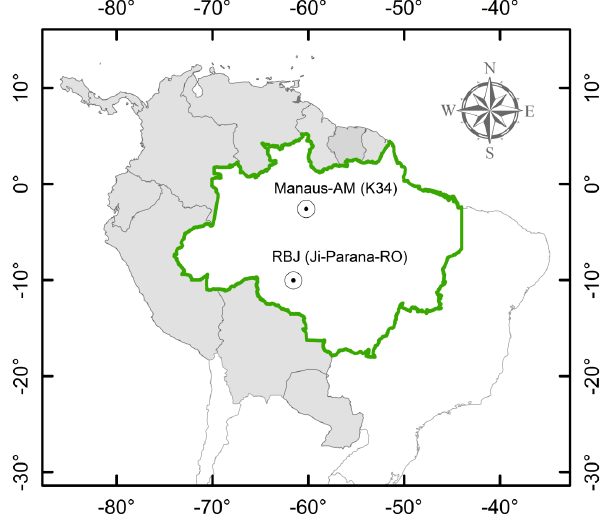
Figure 1. Map of the study sites: Jaru Biological Reserve (RBJ), close to the city of Ji-Parana, Rondonia, Brazil and Cuieiras Biological Reserve (ZF-2, also called LBA tower K34), in Manaus, Amazonas, Brazil.